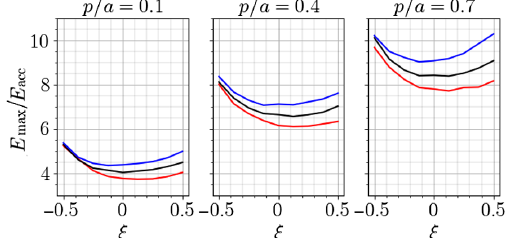
FIG. 9. Normalized peak surface E fields of the minimum radii rectangular corrugation geometry with a= λ ¼ 0 . 53 (red), a= λ ¼ 0 . 60 (black), and a= λ ¼ 0 . 67 (blue).